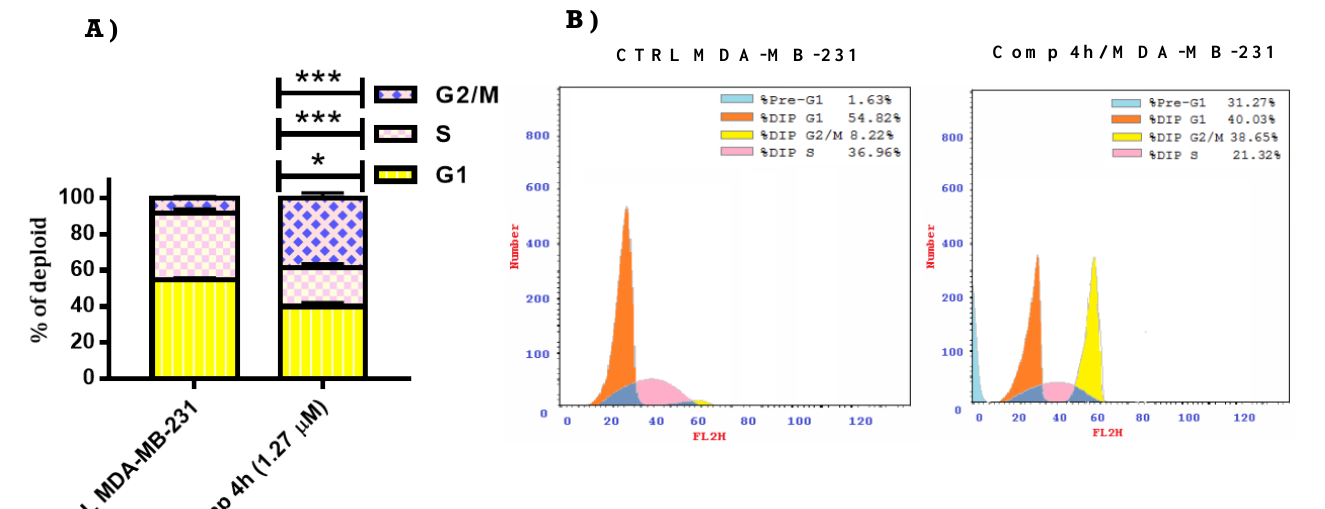
Figure 4. (A) Graphical representation for the effect of Schiff base 4h on the cell cycle profile of MDA-MB-231 cells after 24 h. ( B) Effect of Schiff base 4h on the cell cycle profile of MDA-MB-231 cells after 24 h. All values are presented as mean value ± SD and statistical analyses were carried out using one-way analysis of variance (ANOVA) followed by Tukey’s multiple comparison test (* p < 0.05, *** p < 0.001).